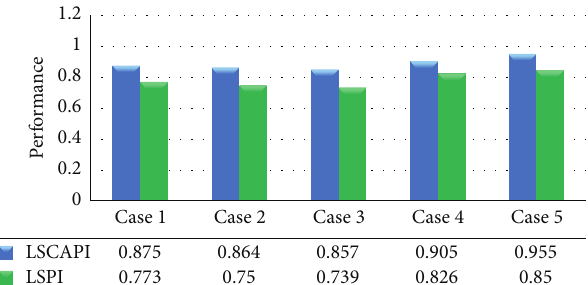
Figure 14: LSPI versus LSCAPI generated solution cases perfor-